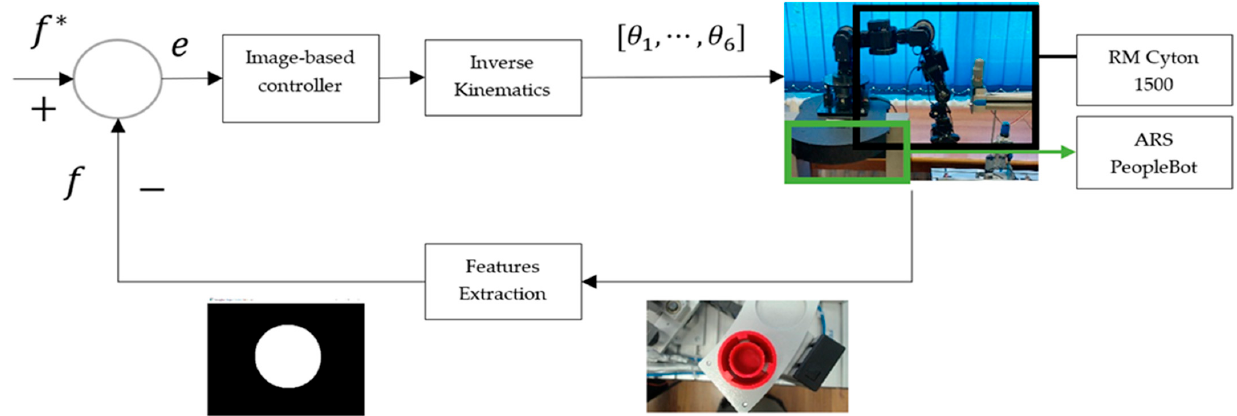
Figure 4. Eye in hand MVS closed-loop control.